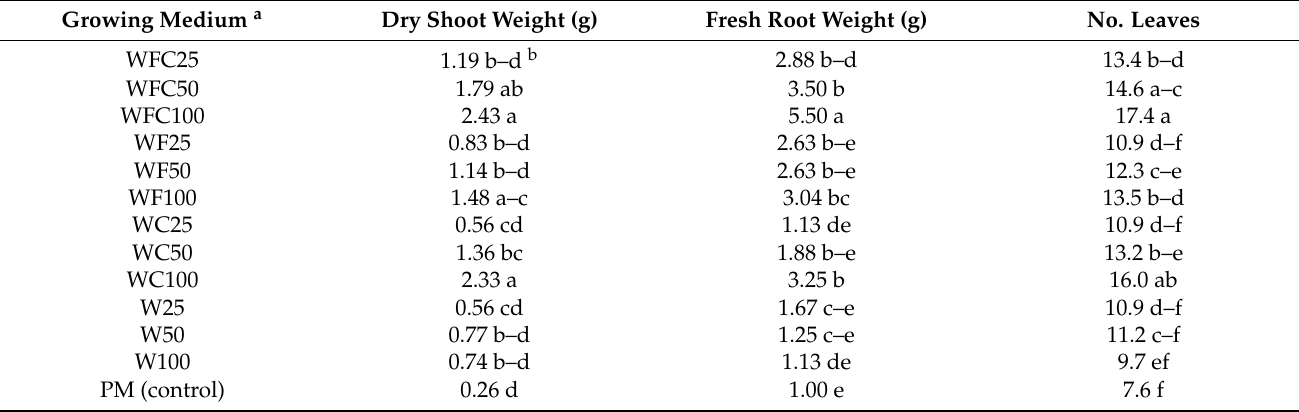
Table 6. Effects of growing medium on dry shoot weight and the number of leaves of lettuce in Trial 2. Growing Medium